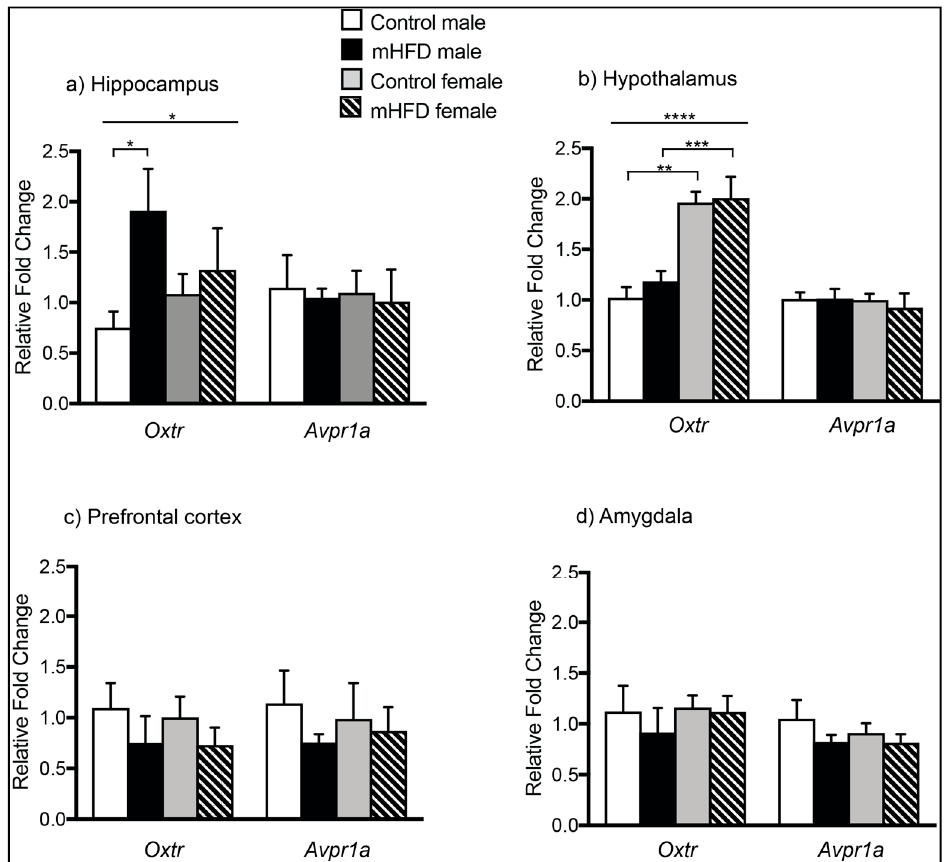
Figure 1. Maternal high fat diet-induced obesity modulates expression of Oxtr mRNA in male offspring hippocampus at GD 17.5. Bar graphs depicting mRNA expression of Avpr1a and Oxtr in maternal high fat diet (mHFD) offspring relative to controls in: ( a ) hippocampus; ( b ) hypothalamus; ( c ) prefrontal cortex; and ( d ) amygdala. Data normalized to reference genes are expressed relative to control males as mean FC ± SEM, with p ≤ 0.05 *, p ≤ 0.01 **, p ≤ 0.001 ***, p ≤ 0.0001 ****.